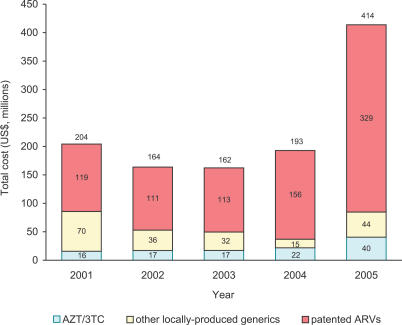
Total ARV Costs in Brazil, 2001–2005